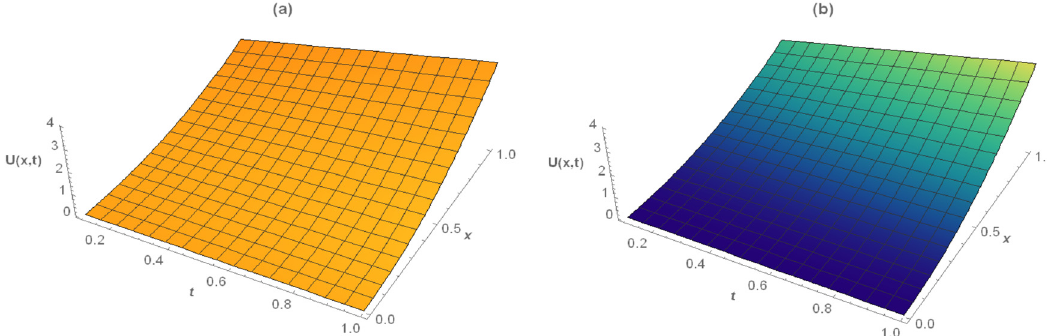
Figure 6: Graphs of approximate solutions for di ff erent time levels at ( a ) α 0.5 = part ( b ) and α 0.75 =